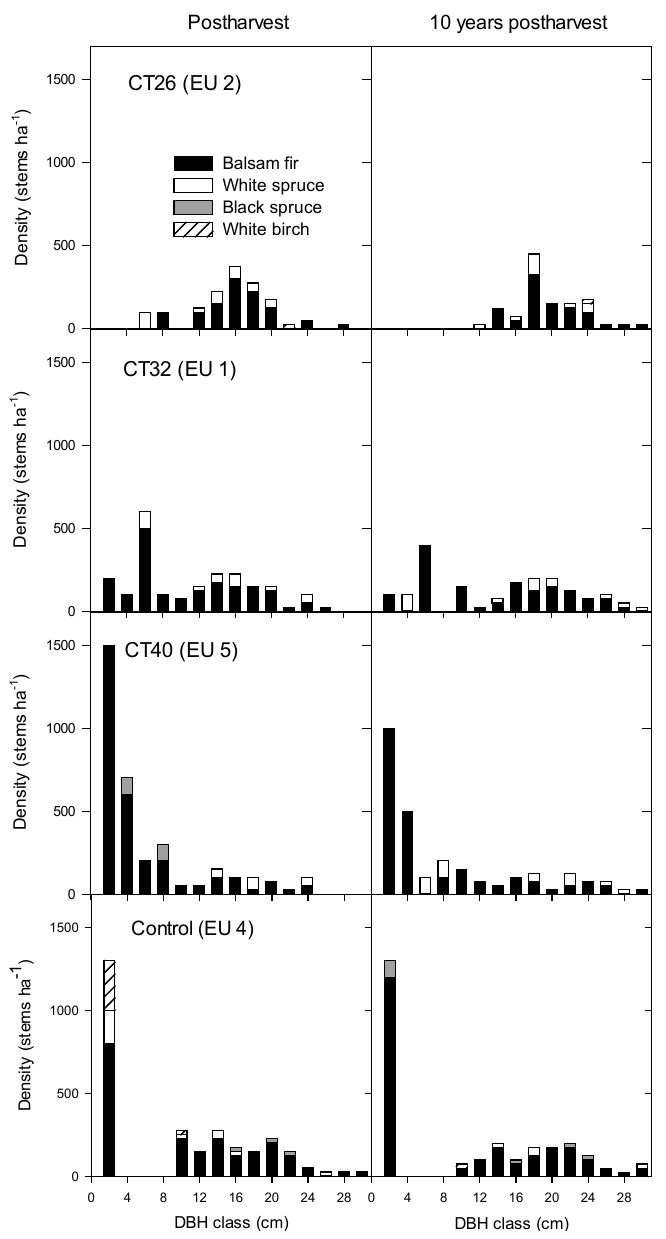
Figure S1. Diameter distribution (2-cm classes) of experimental units (EUs) in each commercial thinning treatment: 26% (EU 2), 32% (EU 1) and 40% (EU 5) merchantable basal area removals and an unthinned control (EU 4). Distributions are presented immediately postharvest and 10 years after